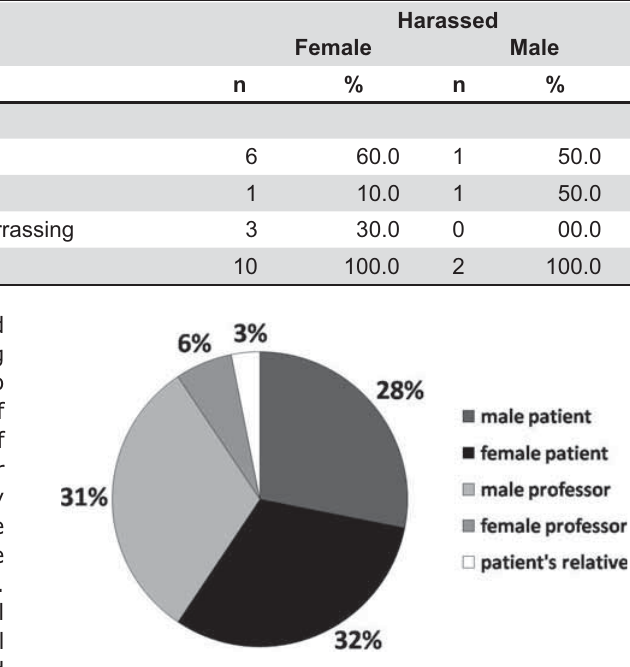
Figure 2- Distribution (%) of dental students sexually harassed according to